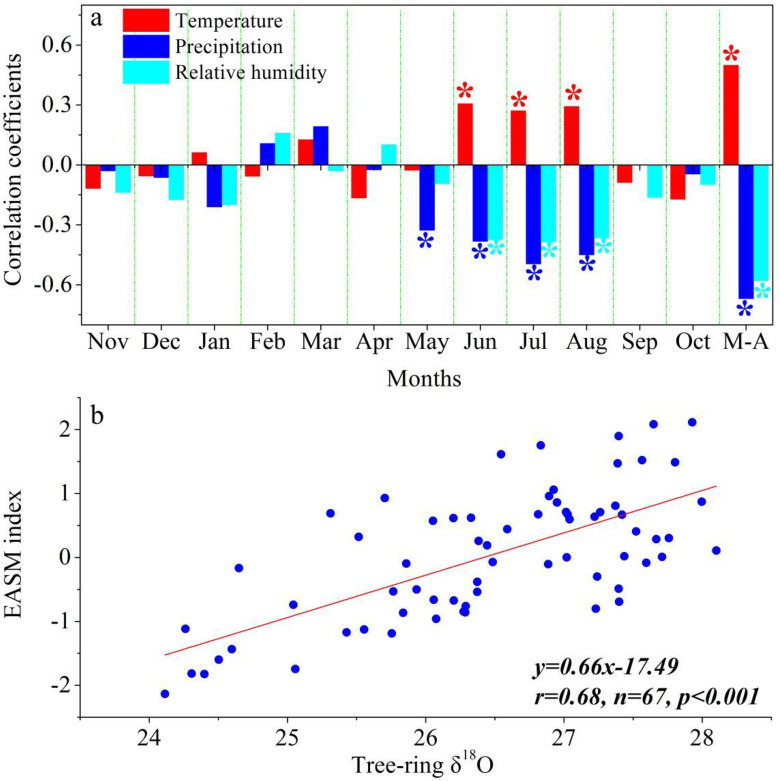
a) Correlations calculated between the tree-ring δ18O chronology and climate variables recorded by Shanghang meteorological station from previous November to current October during the period of 1960–2014. M-A symbolizes the combined months from May to August. Stars indicate the 95% confidence level; b) Relationship between the δ18O chronology and the observed EASM index for the period of 1948–2014.